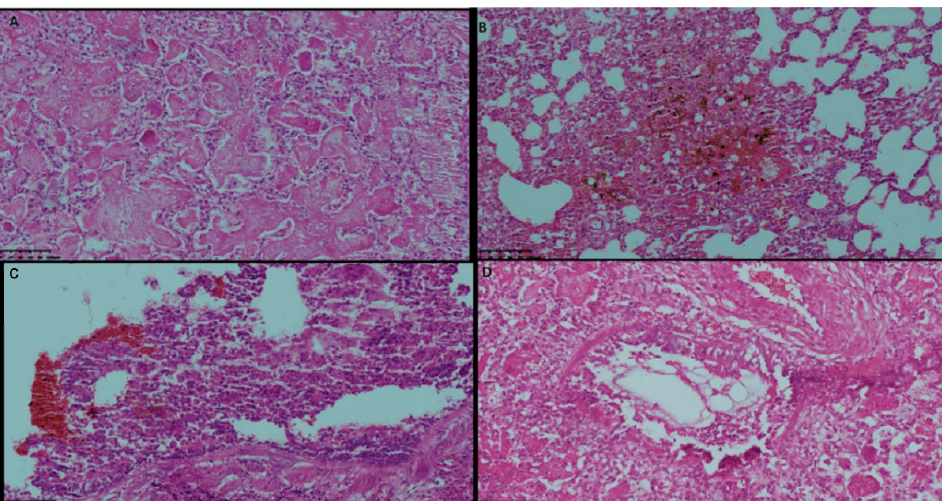
Figure 5. Pathological sections of the dead rhesus macaque after pertussis challenge. ( A ): Thickening of the alveolar septum and infiltration of inflammatory cells in the upper lobe of the left lung. ( B ): Lung consolidation, exudation of alveolar proteins, inflammatory cells, and alveolar septum hemorrhage in the lower lobe of the left lung. ( C ): Destruction of the bronchial epithelium and bronchioles with local suppurative inflammation in the middle lobe of the right lung. ( D ): Mucosal destruction of the bronchial epithelium and bronchioles in the lower lobe of the right